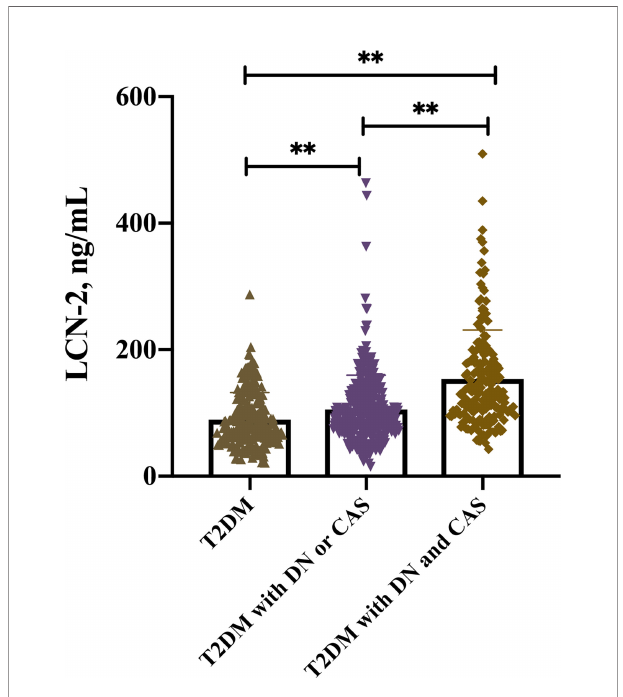
FIGURE 1 | Serum LCN-2 levels in T2DM patients with or without relevant complications including DN and CAP, **P < 0.001.